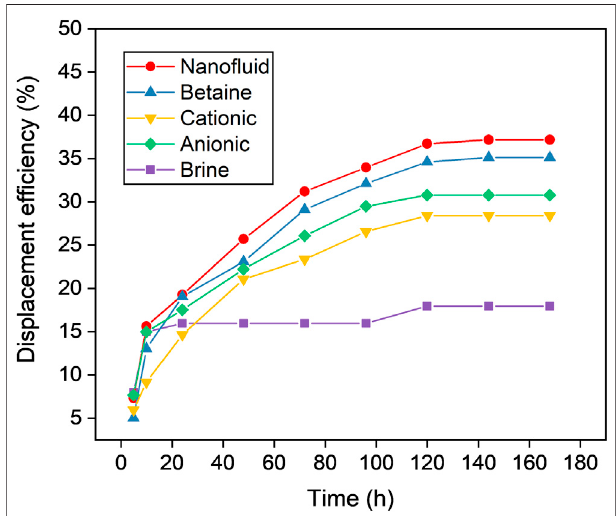
FIGURE 9 | Displacement ef fi ciency of different oil displacement agents (1 mD).